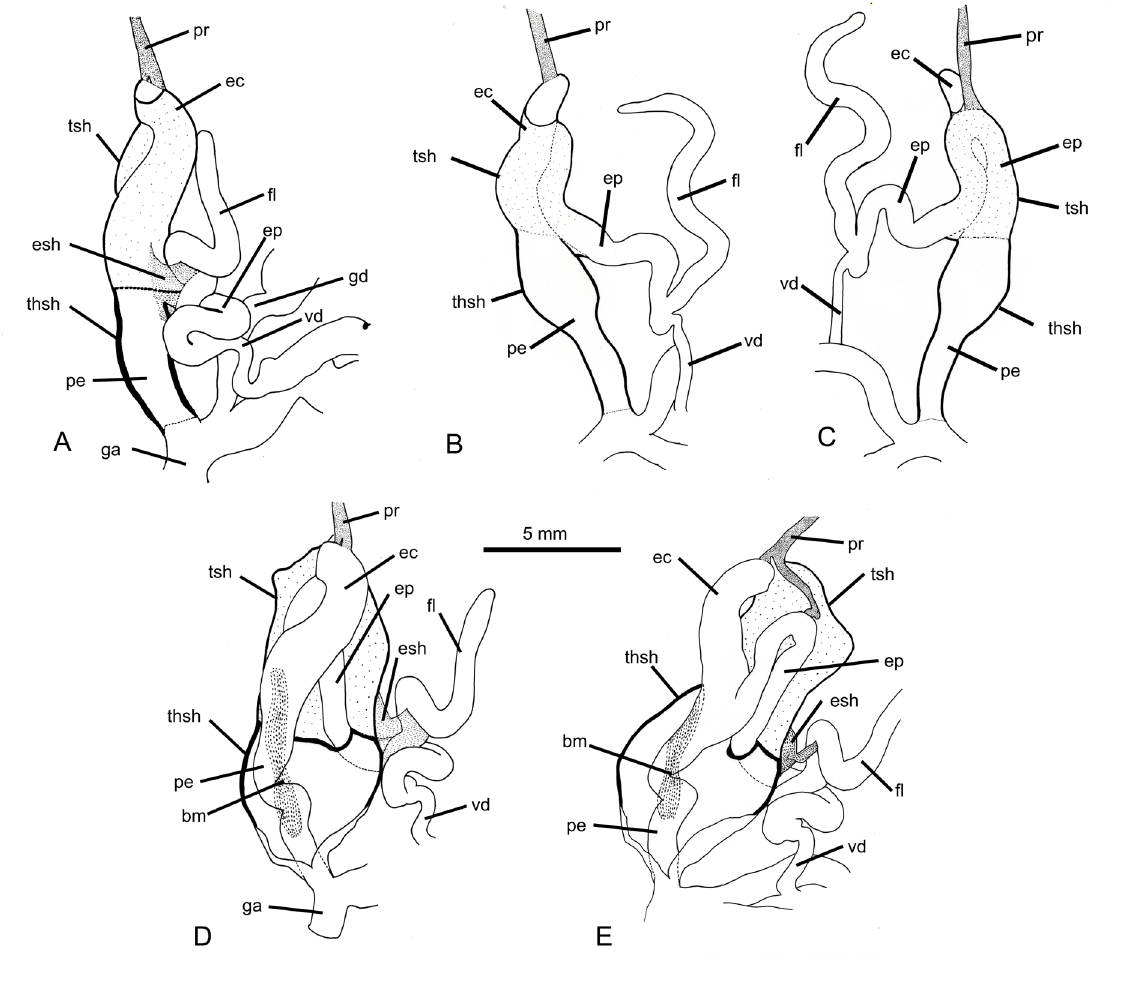
Fig. 9. Male genitalia of the holotype (A, D–E; BNHS GAS 113) and one of the paratypes (B–C; BNHS GAS 116) of Varadia amboliensis Bhosale, Thackeray, Muley & Raheem gen. et sp. nov. A . After dissecting out from the body and with penial sheath in situ. B–C . With extension of penial sheath around epiphallus dissected open; dorsal (B) and lateral (C) views are shown. D–E . With penial sheath cut open; dorsal (D) and lateral (E) views are shown. Thick part of penial sheath shown by bold outline and thin part by dotted outline. Abbreviations: bm = band of muscle; ec = epiphallic caecum; ep = epiphallus; esh = extension of penial sheath around epiphallus; fl = flagellum; ga = genital atrium; gd = gametolytic duct; pe = penis; pr = penial retractor muscle; thsh = thick penial sheath; tsh = thin penial sheath; vd = vas